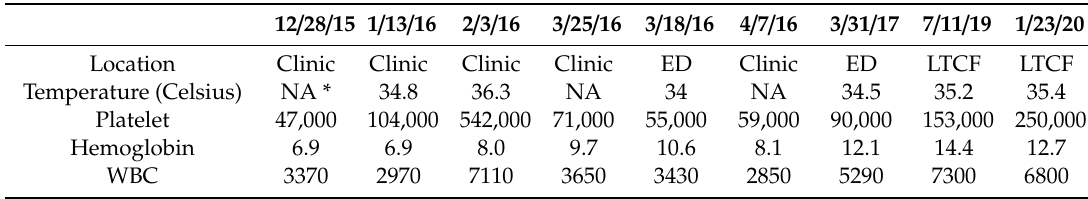
Table 2. Case 2 temperatures and blood cell